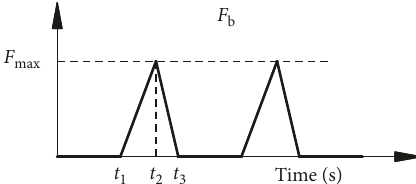
Figure 5: Input force F b in each period when the breaker strikes the ground.